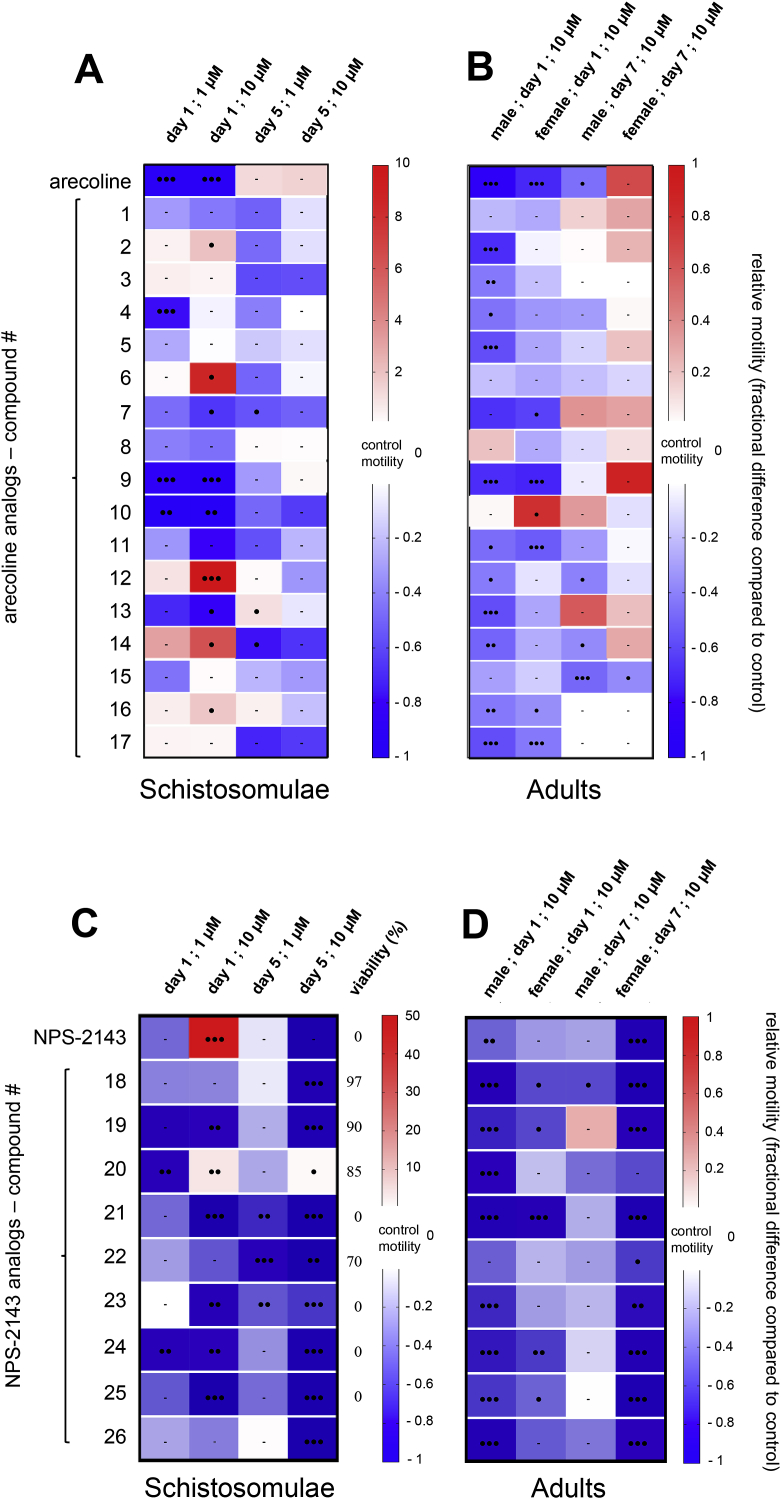
Motility assay on S. mansoni schistosomulae and adults treated with arecoline, NPS-2143 and respective chemical derivatives.Heat maps of selected arecoline (A, B) and NPS-2143 (C, D) chemical analogs tested at 1 and 10 μM on three-day old schistosomulae and at 10 μM on adult worms. Similar experimental conditions used for the secondary screen of Selleckchem® compounds were applied (Fig. 3, Fig. 5). Motility rate was calculated relative to control animals (DMSO-treated). Blue and red colors correspond to hypo- and hypermotility respectively. Black circles indicate p value < 0.0005 (3), <0.005 (2), <0.05 (1). Bars represent no significant change in motility rate compared to control. When indicated, viability percentage was determined on larvae, five days post compound exposure. (For interpretation of the references to color in this figure legend, the reader is referred to the Web version of this article.)